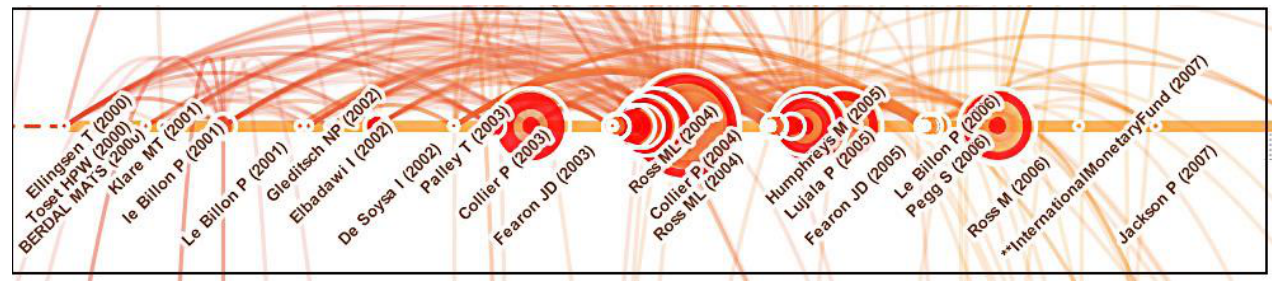
Figure 27. A timeline visualization of the Cluster 5 co–citation network (** means public publications from government or non-government organizations).